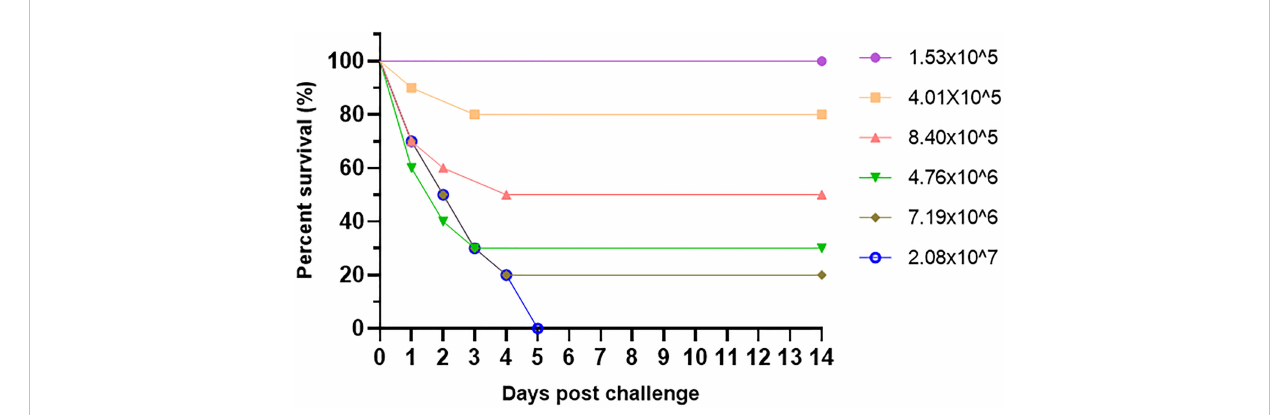
FIGURE 3 Relative survival rate of V. alginolyticus HY9901 infected with pearl gentian grouper at different